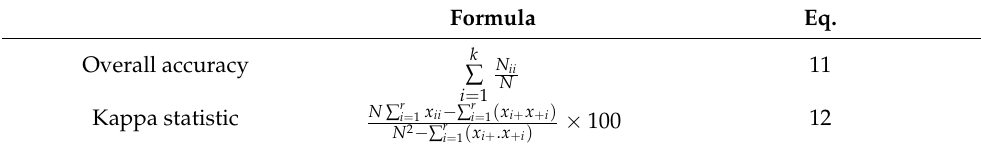
Table 3. Accuracy precision